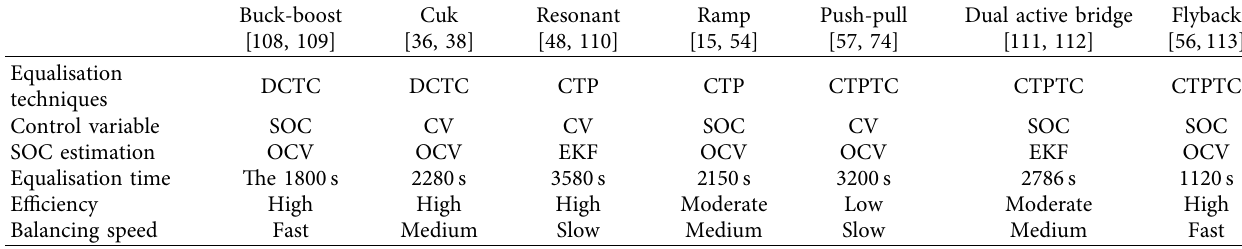
Table 10: Comparison of diferent converter topologies for